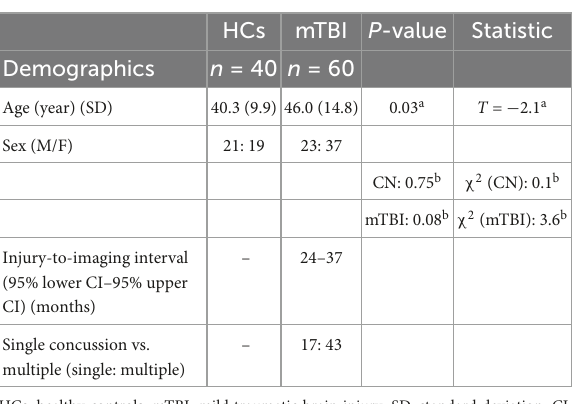
TABLE 2 Demographic of participants in the mTBI and HCs